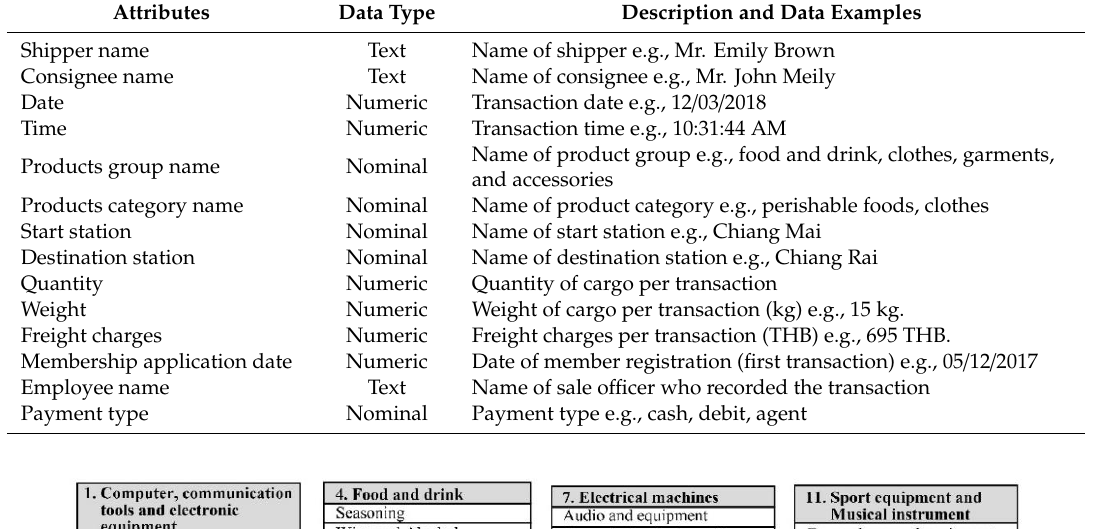
Table 2. Example of sales transaction data.